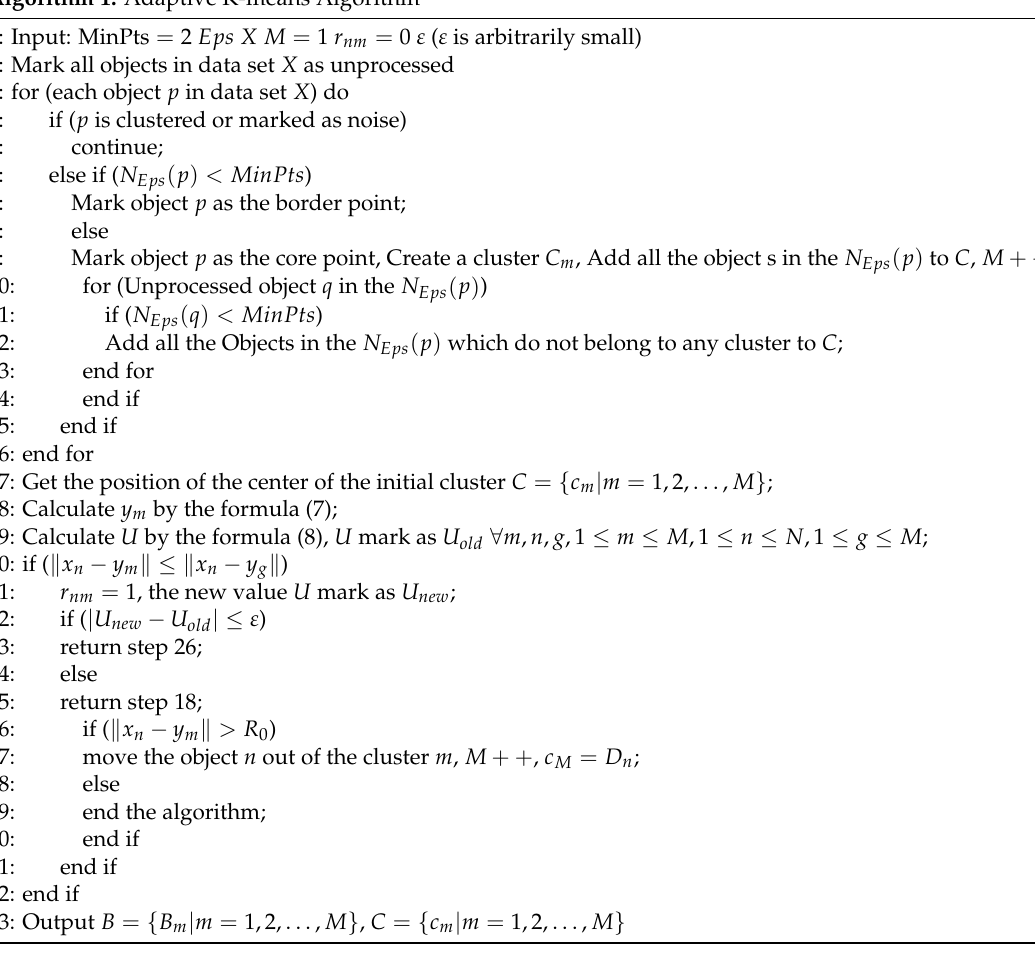
Table 2. The pseudo-code of adaptive K-means algorithm. Algorithm 1. Adaptive K-means